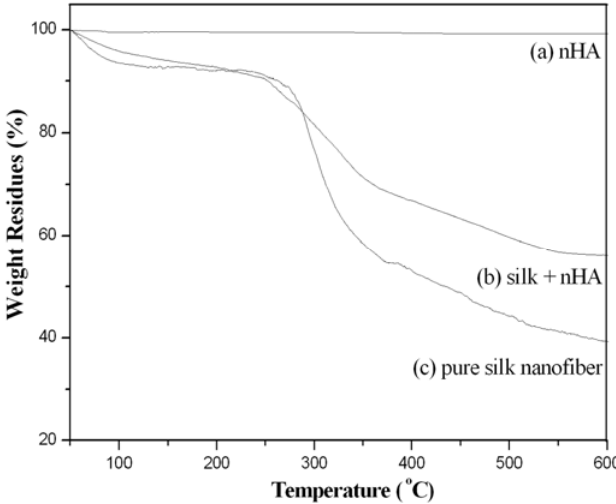
Figure 11. ( a ) TGA curves of pure nHA; ( b ) mineralized silk/nHA nanofibers; and ( c ) pure silk